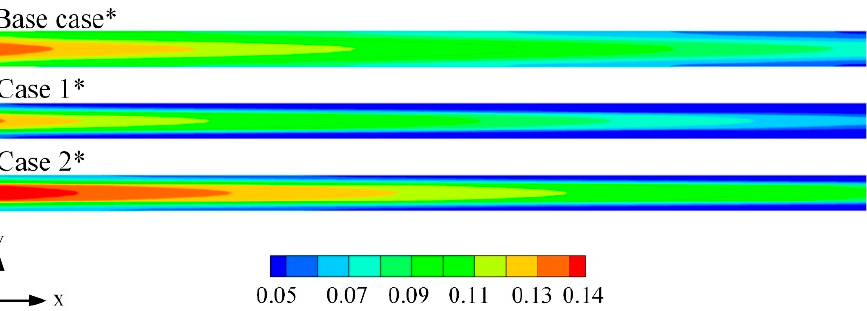
Figure 6. Distribution of oxygen mass fraction in the cathode channel cross sectional plane near the cathode inlet (z = 5 mm) when the operating voltage is 0.6 V in the Base case*, Case 1* and Case 2*.